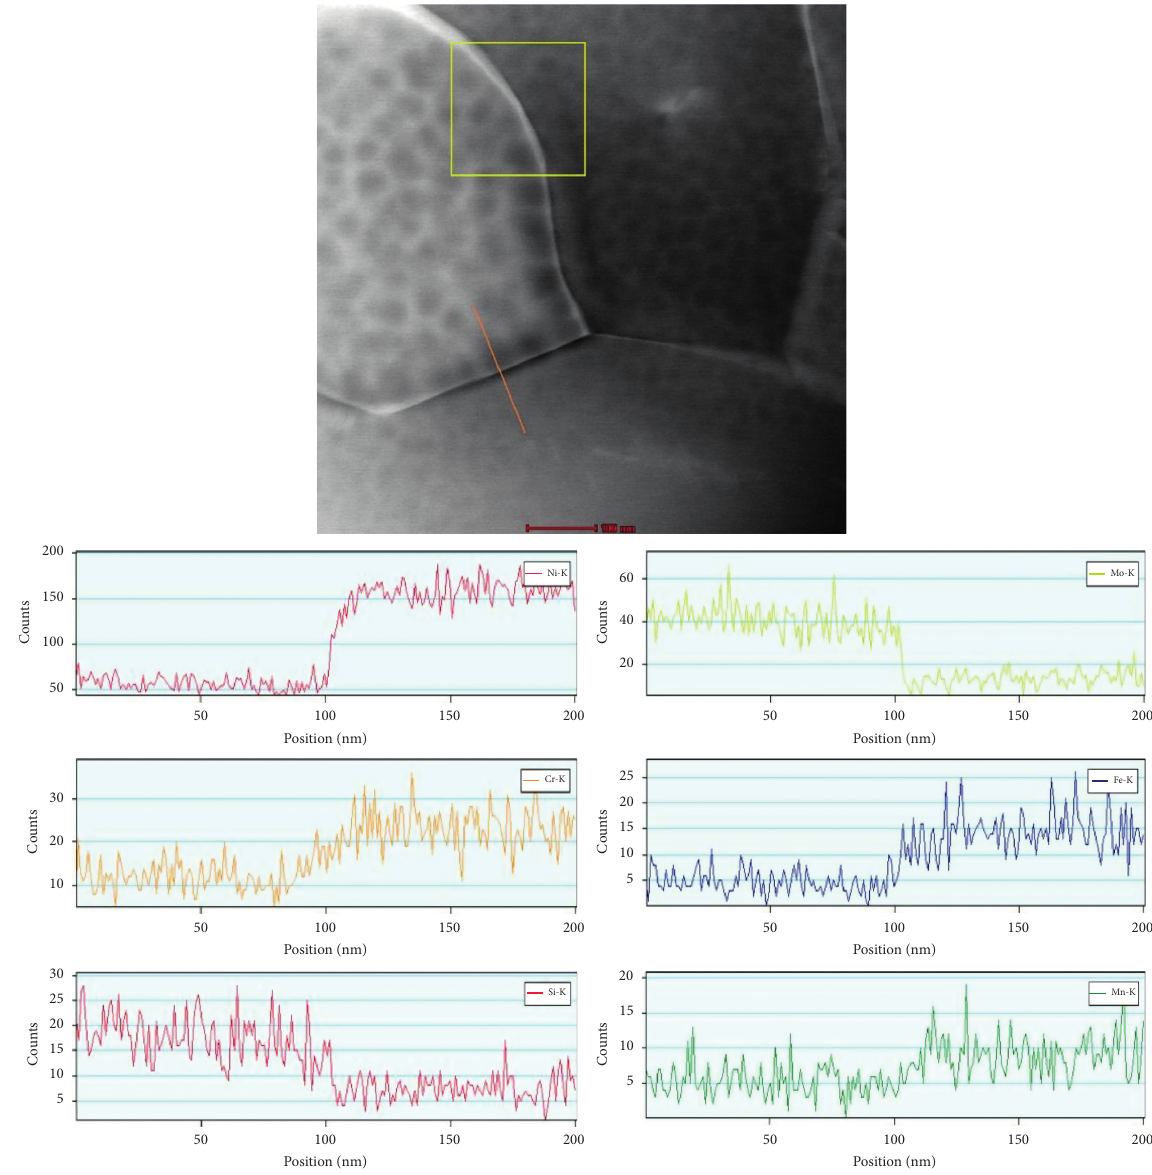
Figure 7: Distribution of elements in the second phase and Hastelloy N